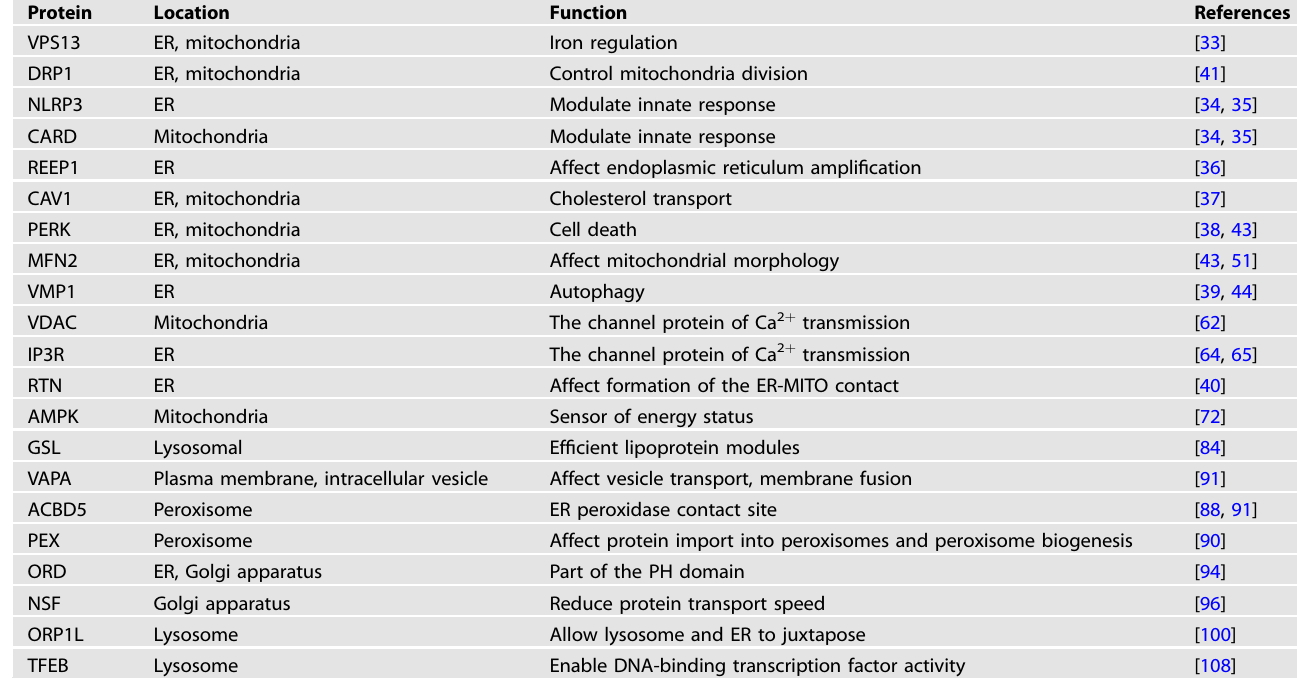
Table 1. Some reported proteins playing a role in organelle